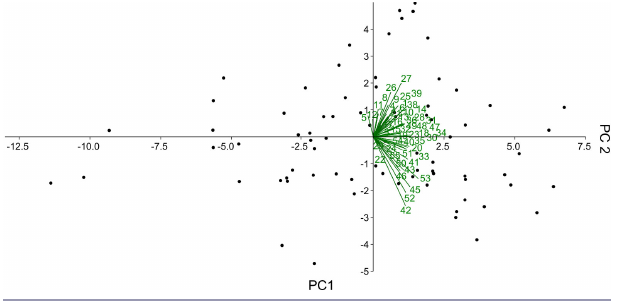
Fig. 1 . Principal component analysis (PCA) reporting the distribution of hiking guides scores (points) and loading vectors deriving from the 55 quantitative questions, with the first and second principal components explaining 24.3 % and 7.7% of the variance, respectively.